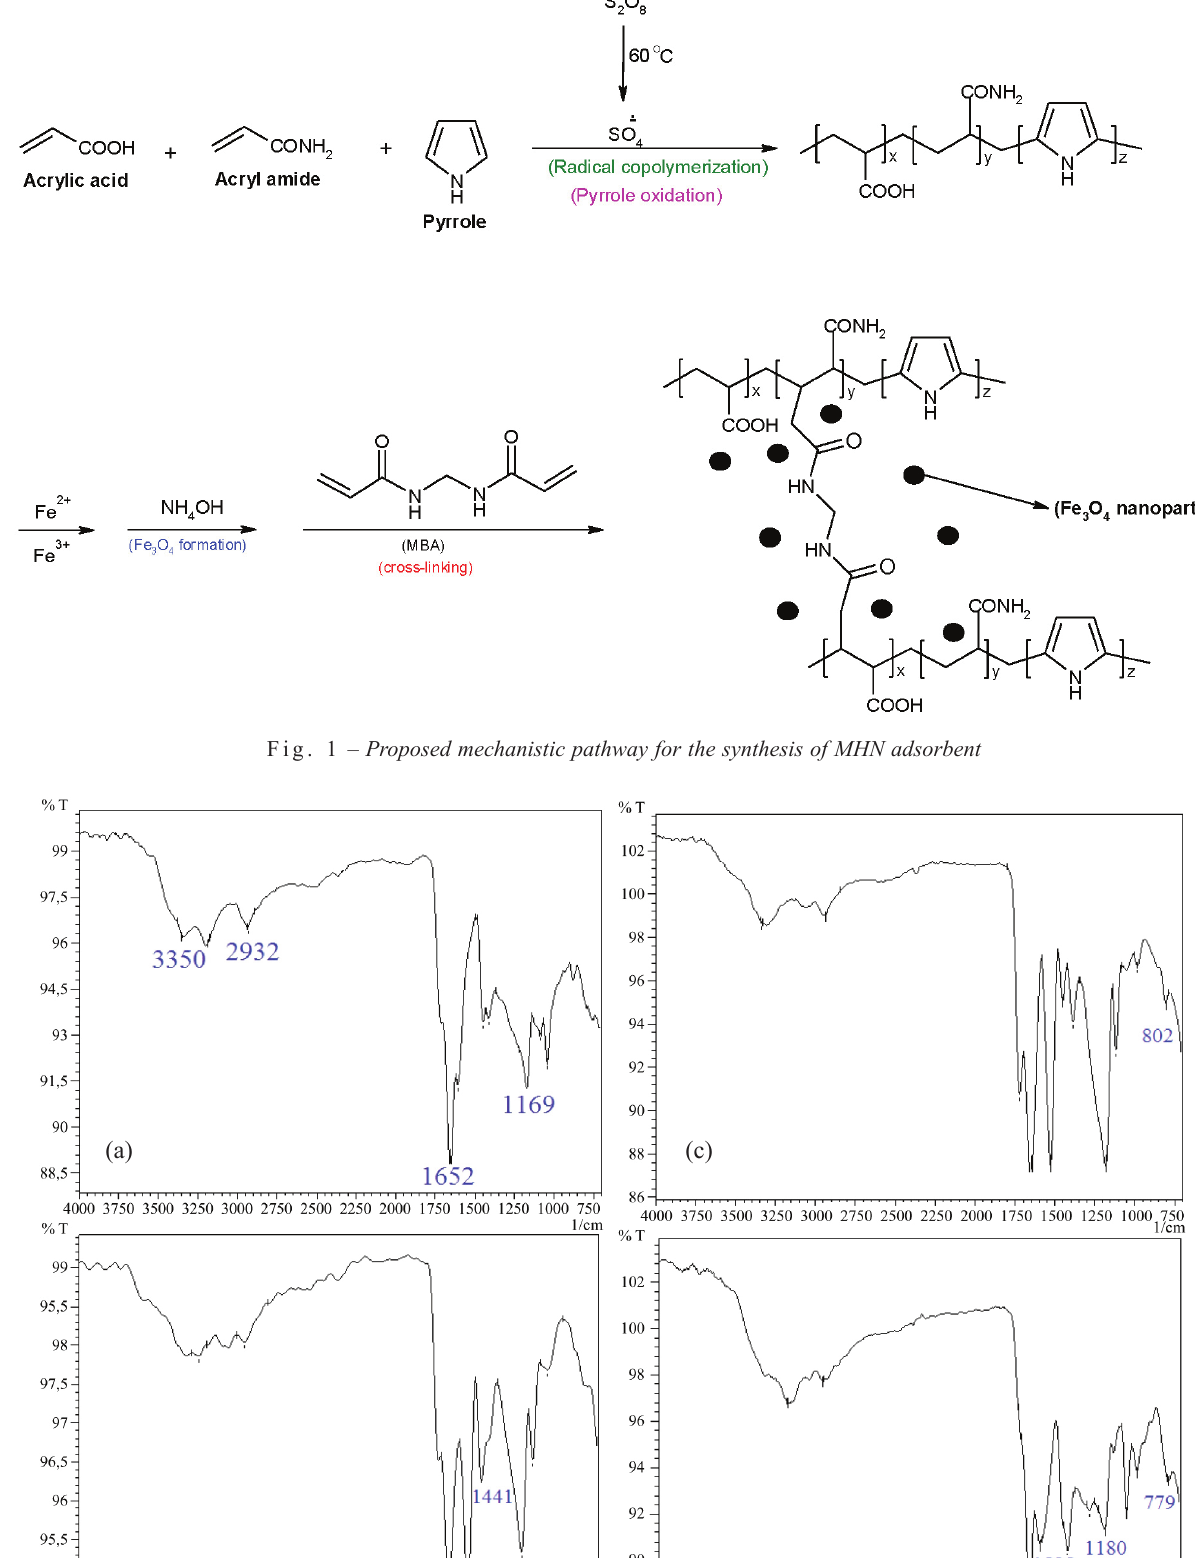
Fig. 2 – FTIR spectra of poly(Py) hydrogel (a), poly(AA-co-AM) hydrogel (b), poly(AA-co-AM)/Fe adsorbent